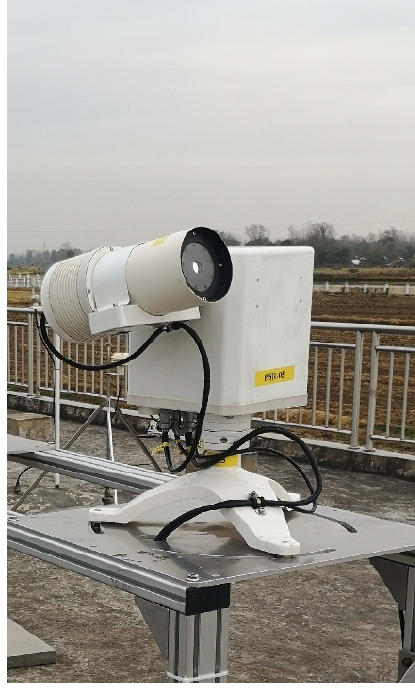
Figure 1. The PSR deployed in Shouxian.